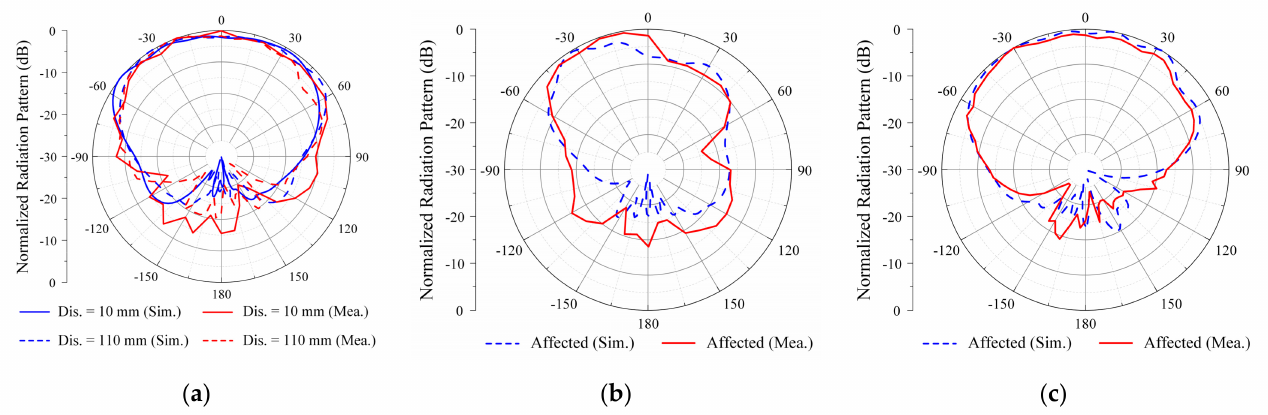
Figure 11. Simulated and measured normalized patterns of the patch antenna in the yz plane at 6 GHz: ( a ) unaffected radiation patterns with distance = 10 mm (solid lines) and 110 mm (dashed lines), ( b ) affected radiation pattern at distance = 10 mm, and ( c ) affected radiation pattern at distance = 110